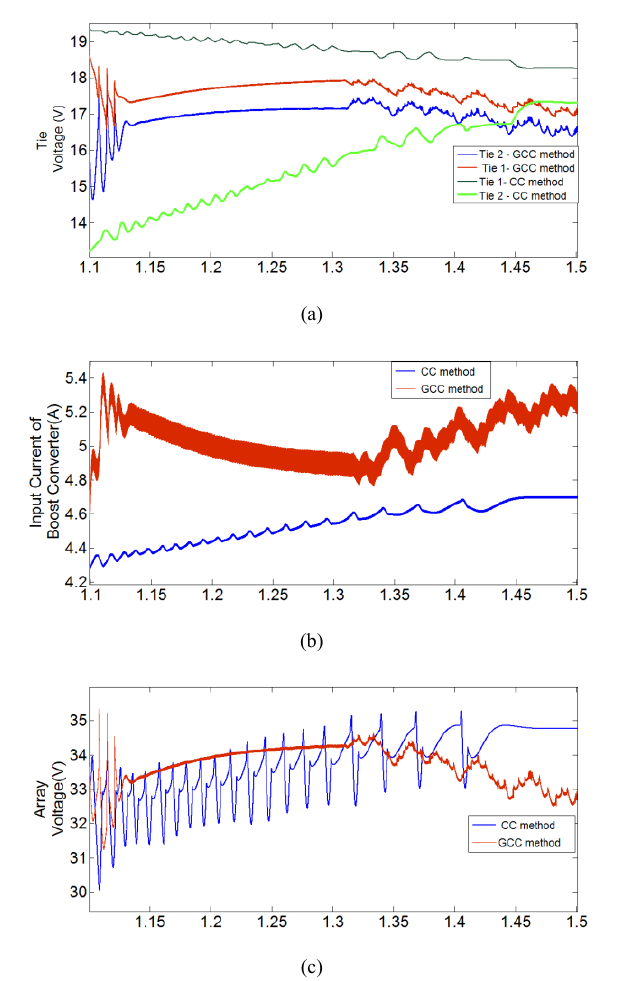
Fig. 8 Zoomed waveforms: (a) voltages of tie-1 and tie-2, (b) input current of boost converter, (c) PV array voltage Each row of Table-II shows maximum output power of PV array with different shading pattern. G_PV ij indicates the irradiance on PV module PV ij , while P o_wo_fc stands for maximum power obtained in absence of flyback converters. P o_CC represents the maximum power tracked with TCT-CC method and P o_GCC represents the maximum power tracked with TCT-GCC method. It is observed that the GCC method significantly enhances the amount of output power of the array under partially shaded conditions compared to TCT-CC method.